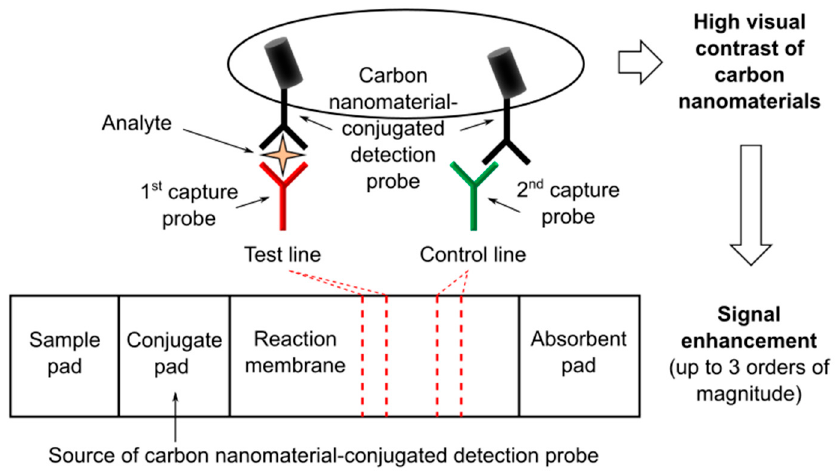
Figure 4. Schematics of a LFT based on the use of carbon nanomaterials, e.g., carbon nanotubes (CNTs), as labels for signal enhancement.